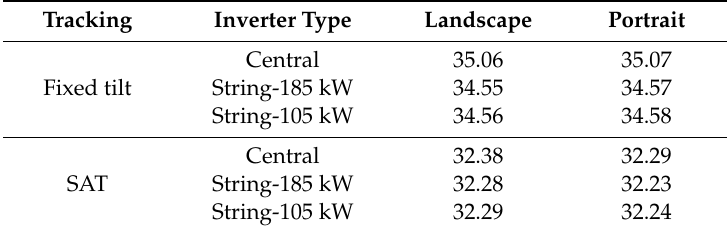
Table 4. Levelized cost of energy (LCOE) ( € /